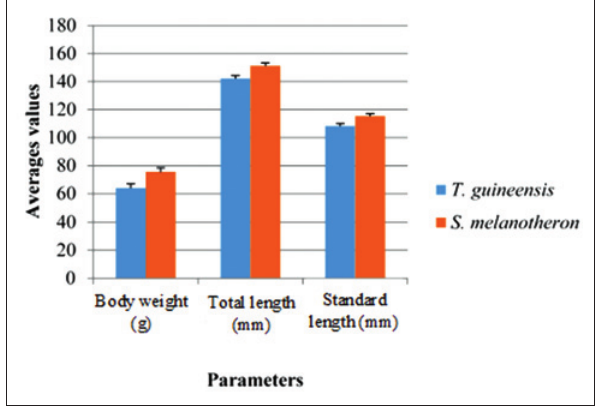
Figure-6: Morphometric parameters of Tilapia guineensis and Sarotherodon melanotheron compared in different